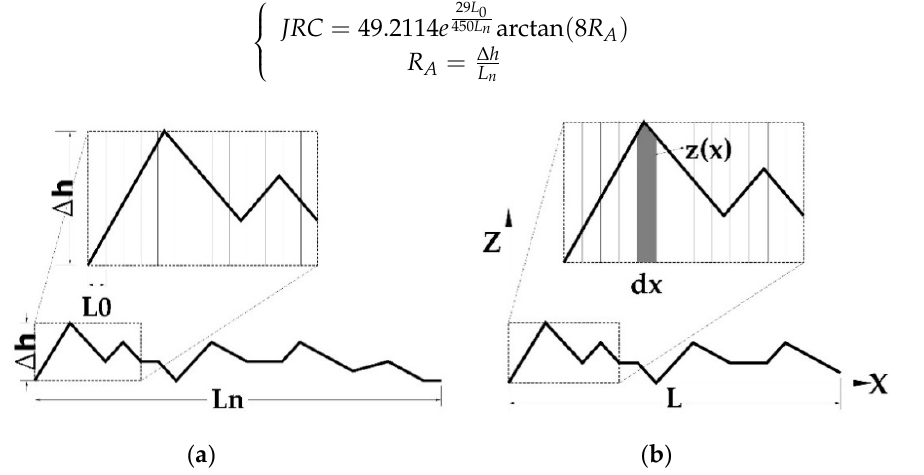
Figure 3. Roughness definition method to define roughness curves: ( a ) roughness parameters L n and L 0 measured in the roughness curves and ( b ) z x d x and L from the roughness curves.